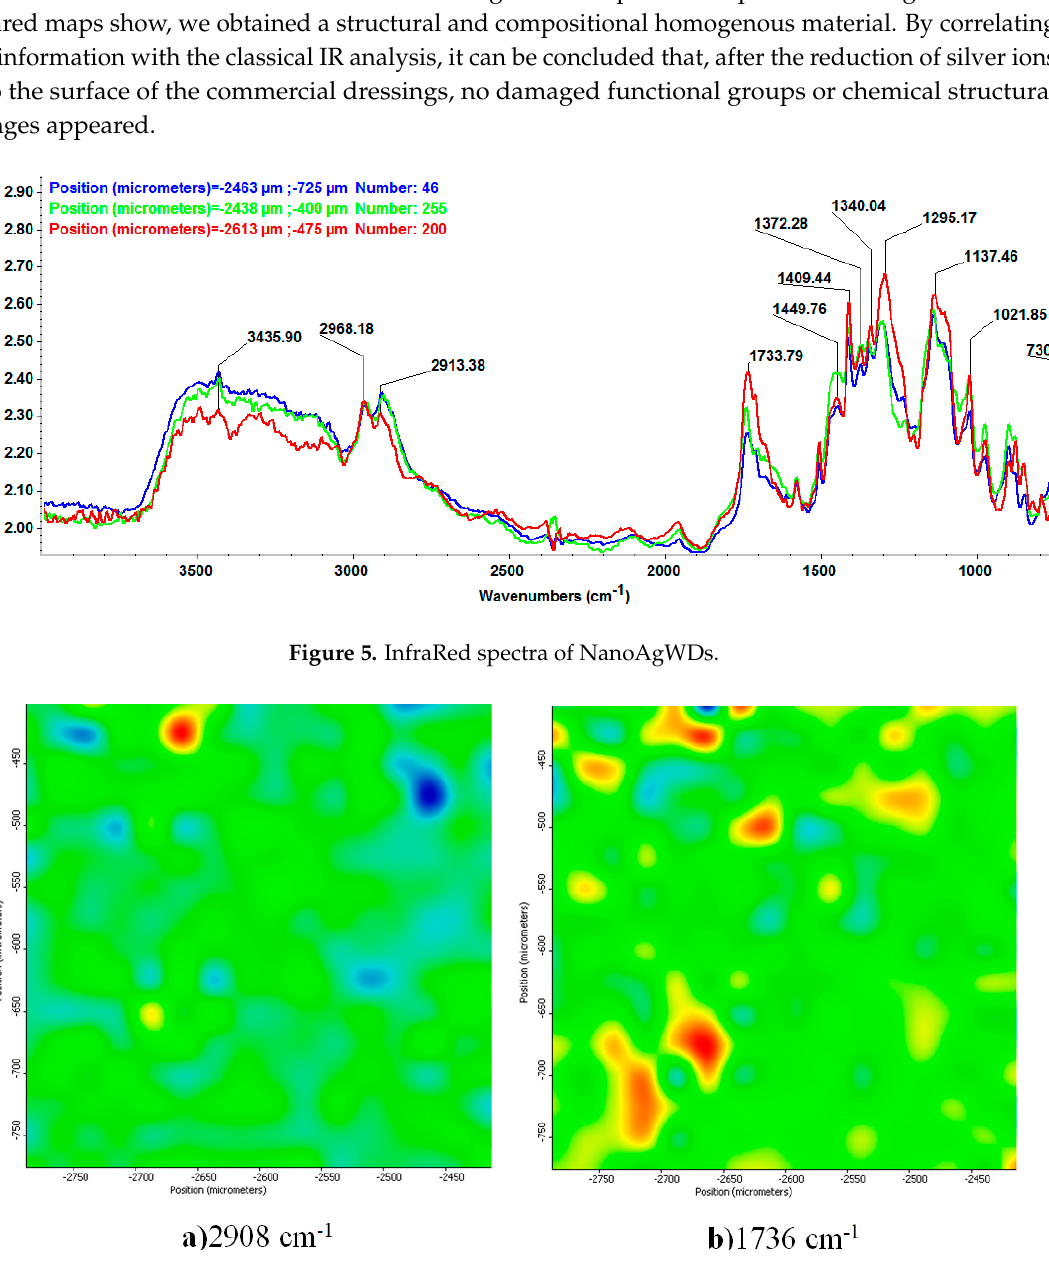
Figure 6. IR maps of NanoAgWDs: Intensity distribution of: ( a ) 2908 cm − 1 (CH 3 ); and ( b ) 1736 cm − 1 (C=O) wavenumbers.